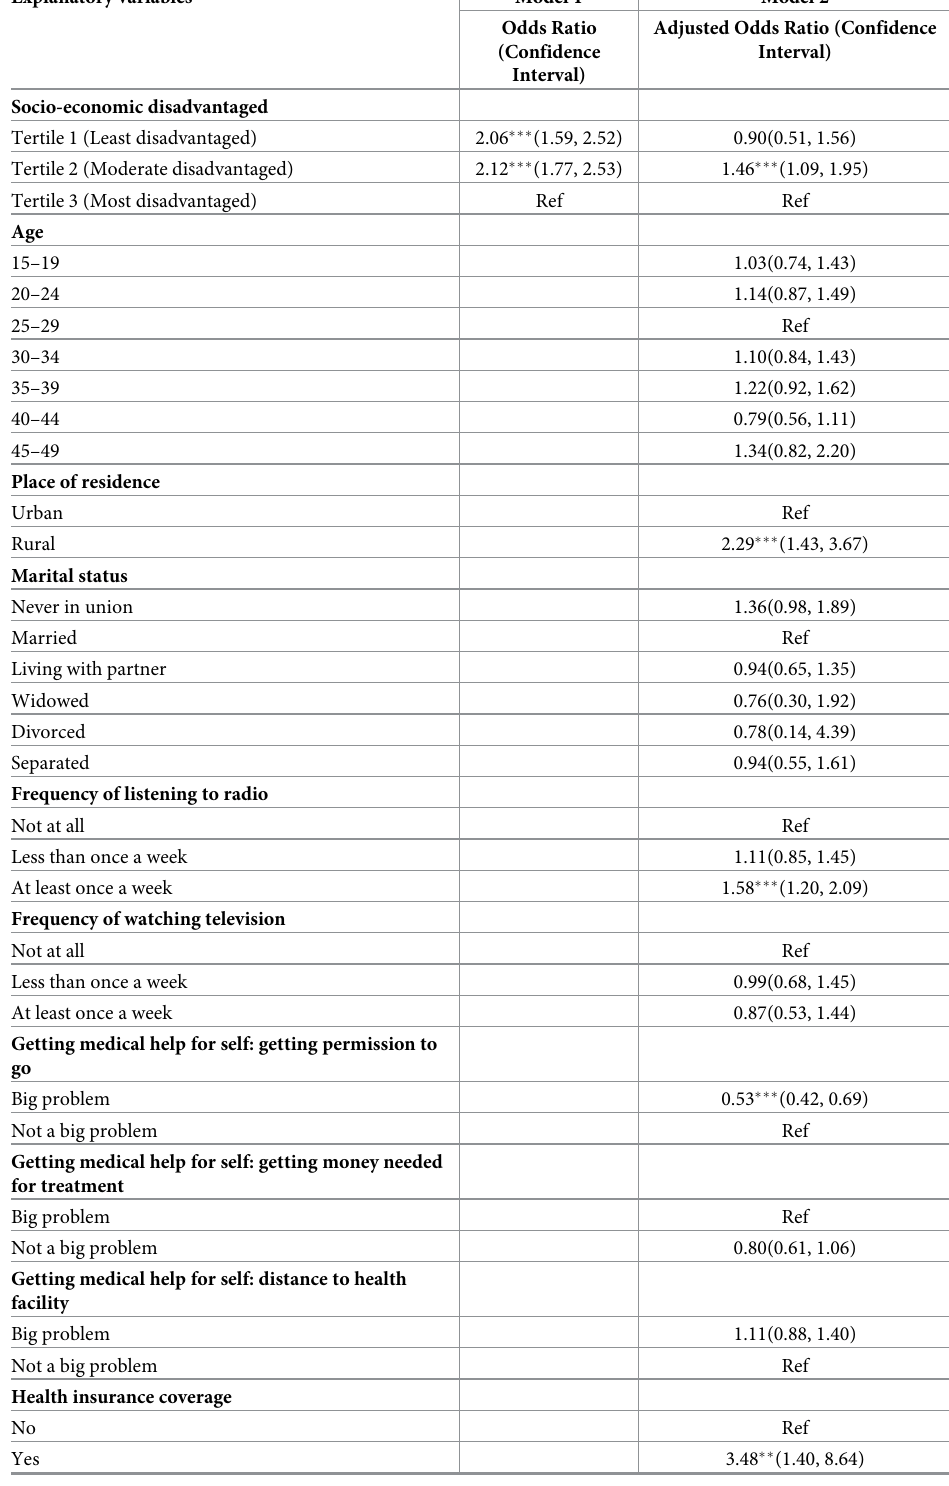
Table 3. Binary logistic regression results on explanatory variables and quality